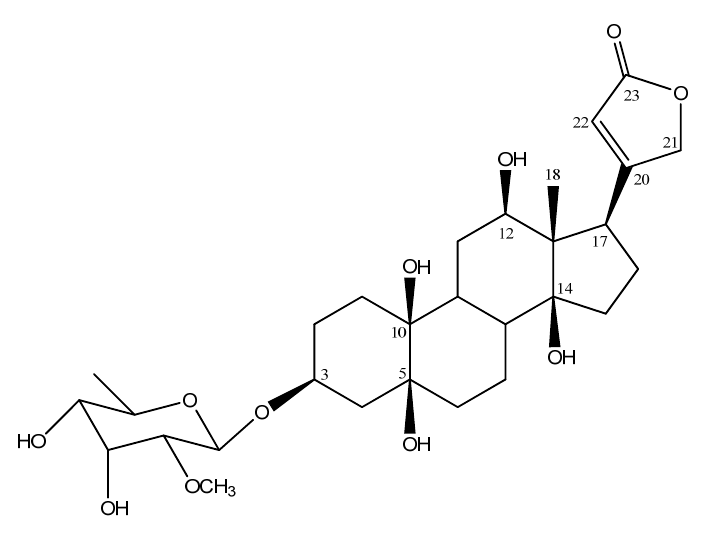
Figure 1. Structure of compound 1 .